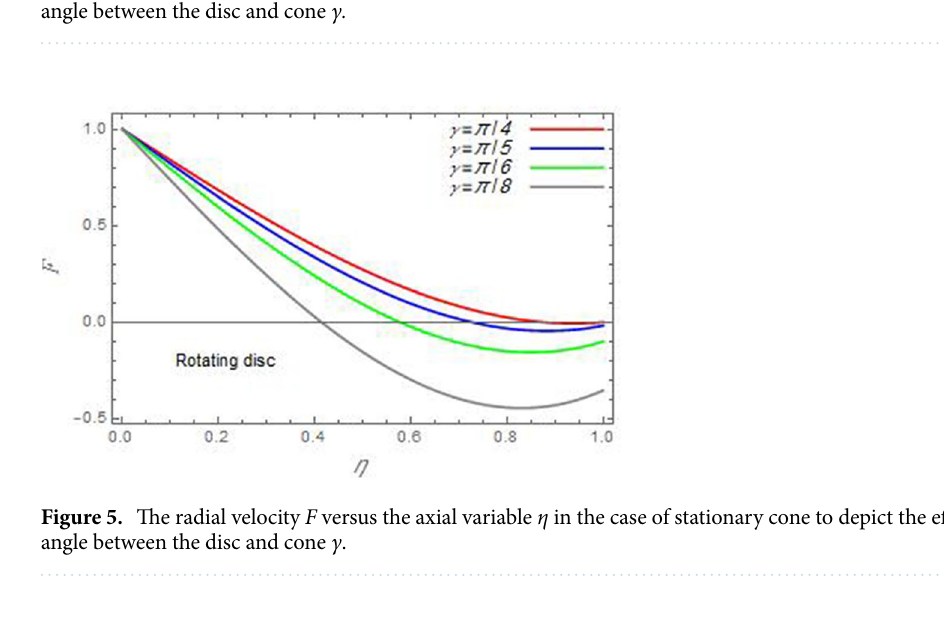
Figure 4. The radial velocity F versus the axial variable η in the case of stationary disc to depict the effect of the angle between the disc and cone γ.